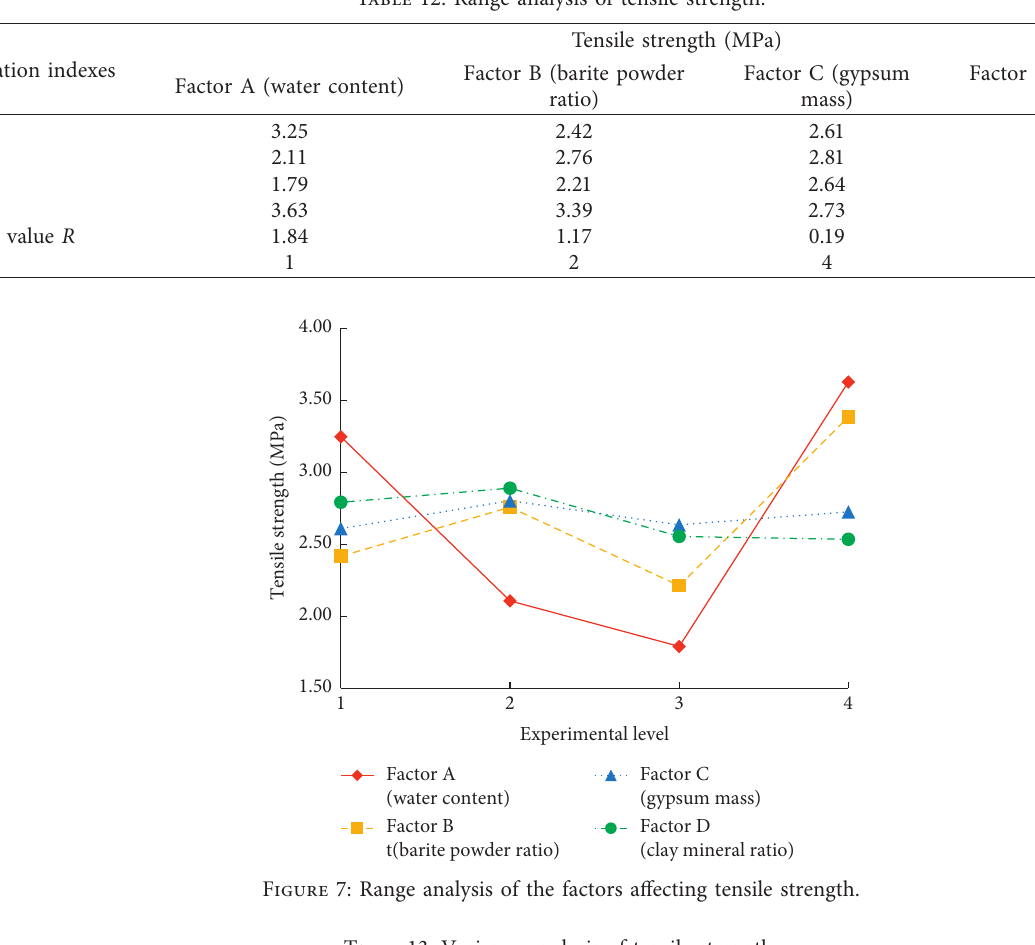
Table 12: Range analysis of tensile strength.